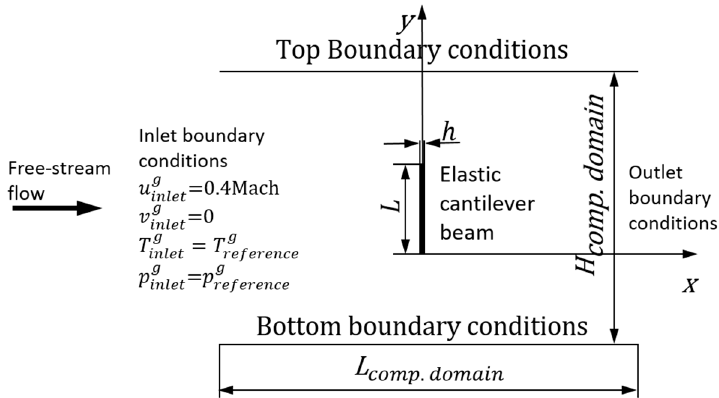
Figure 1. Geometry of flow past elastic cantilever beam placed normal to free stream.